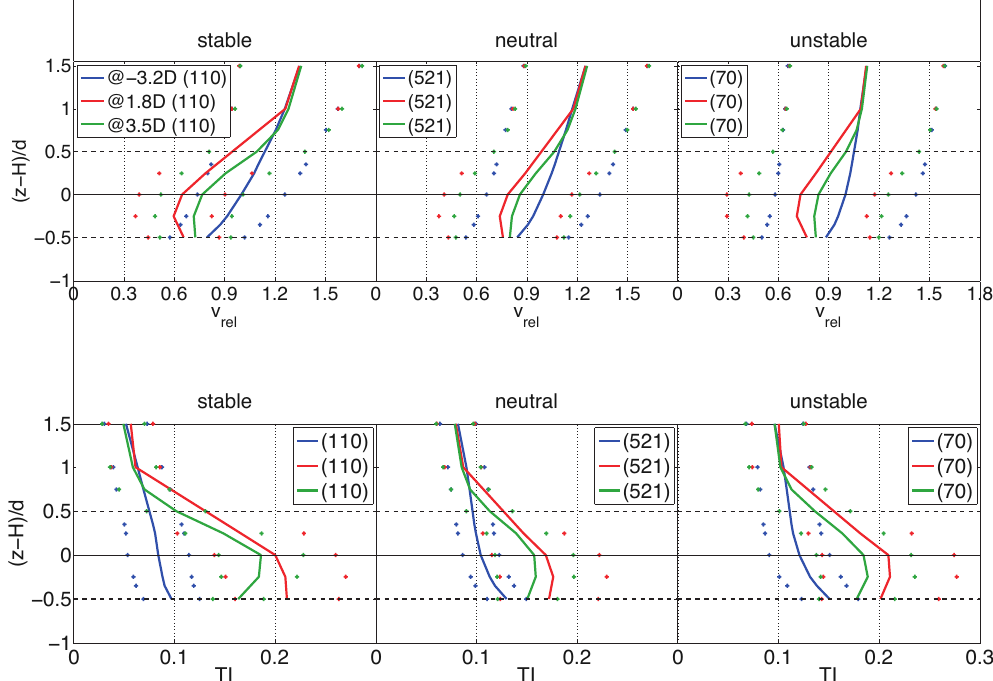
Figure 5. Mean normalized profiles of wind speed v rel (upper panels) and turbulence intensity TI (lower panels) filtered for the different stability classes and averaged over all cases in the wind direction interval 217 ◦ –237 ◦ . The individual 10min average wind speeds of all three LiDAR systems have been normalized by the corresponding 80m value of the upstream LiDAR wls67 before averaging over the number of available profiles indicated in the legend. Dots indicate the standard deviation at each measurement altitude before the